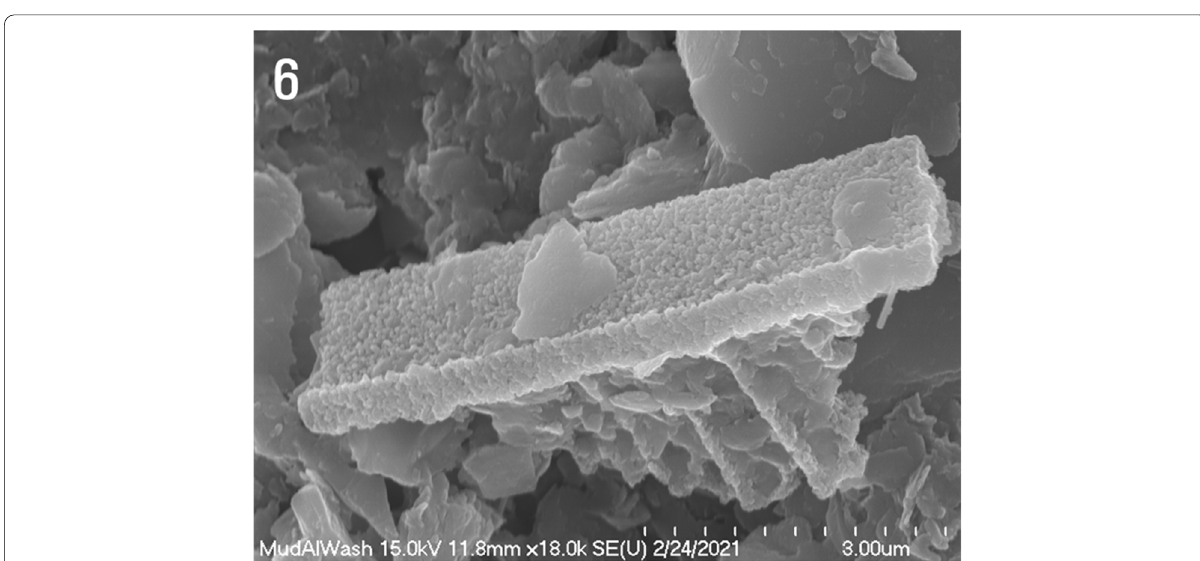
Fig. 6 High-magnification scanning electron micrograph of a silica frustule with a thickness of to 2.5